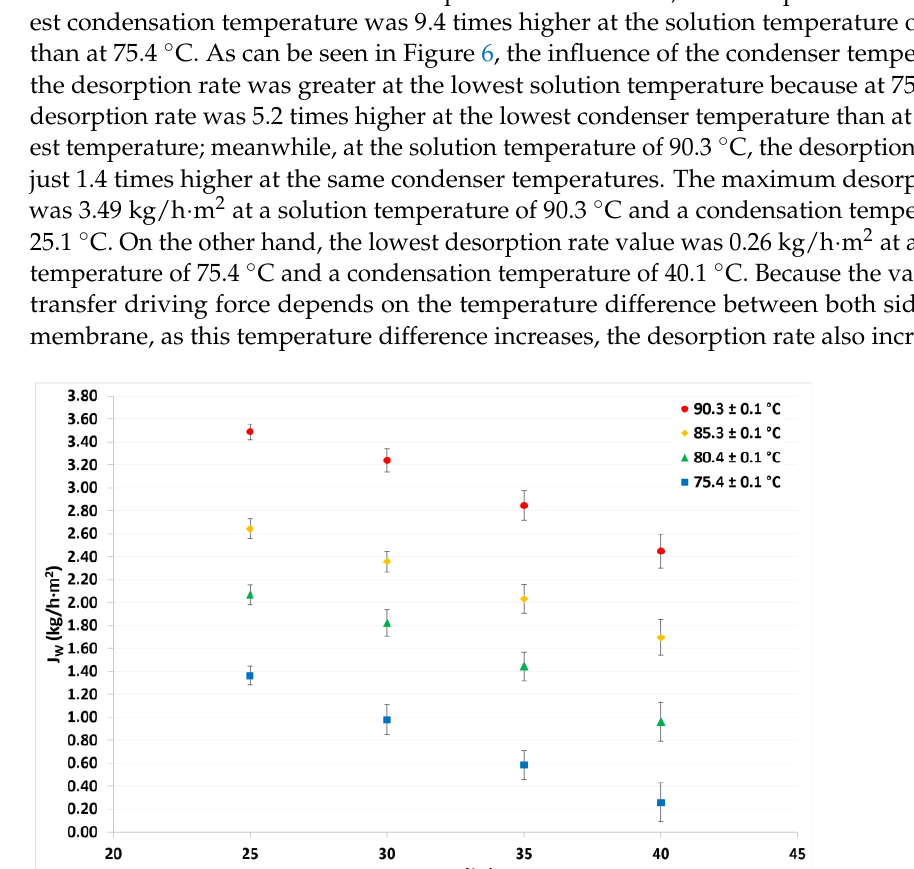
Table 5. Comparison of the experimental desorption rates for membrane desorbers re- ported in the literature.